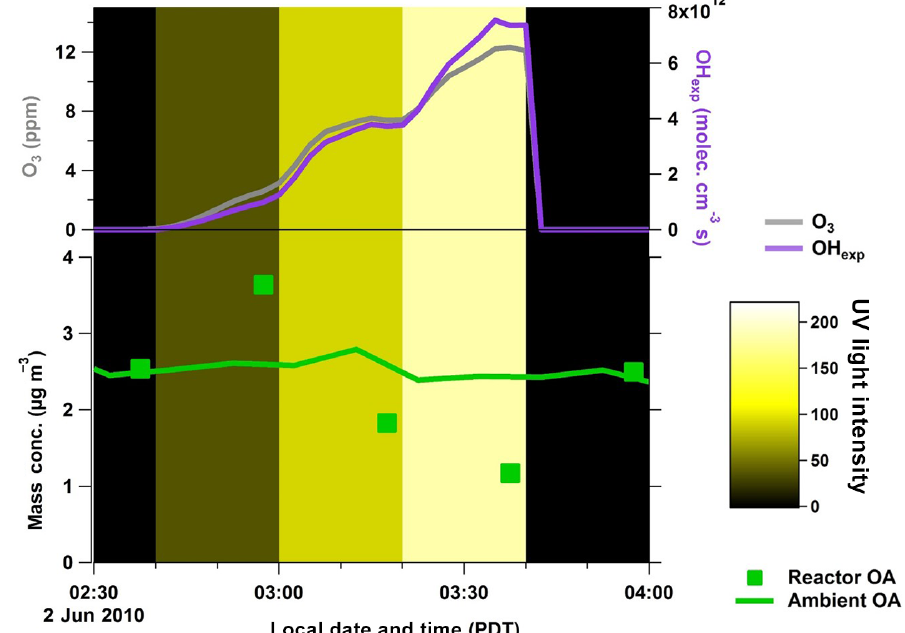
Figure 2. A typical OFR sampling cycle, including four steps in lamp intensity in the reactor. Top: reactor oxidant concentrations. Bottom: OA concentration for ambient and reactor output sampling. The UV light intensity color scale corresponds to the sum of the AC voltages applied to the two lamps in the reactor. Only at the highest lamp setting are both lamps on, while at lower settings only one of the lamps is